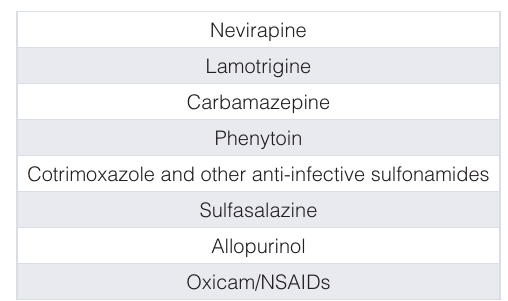
Table 4. Medications associated with high risk of